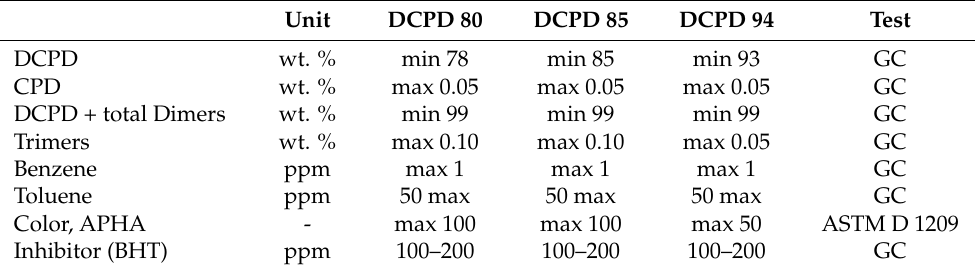
Table 1. Dicyclopentadiene product